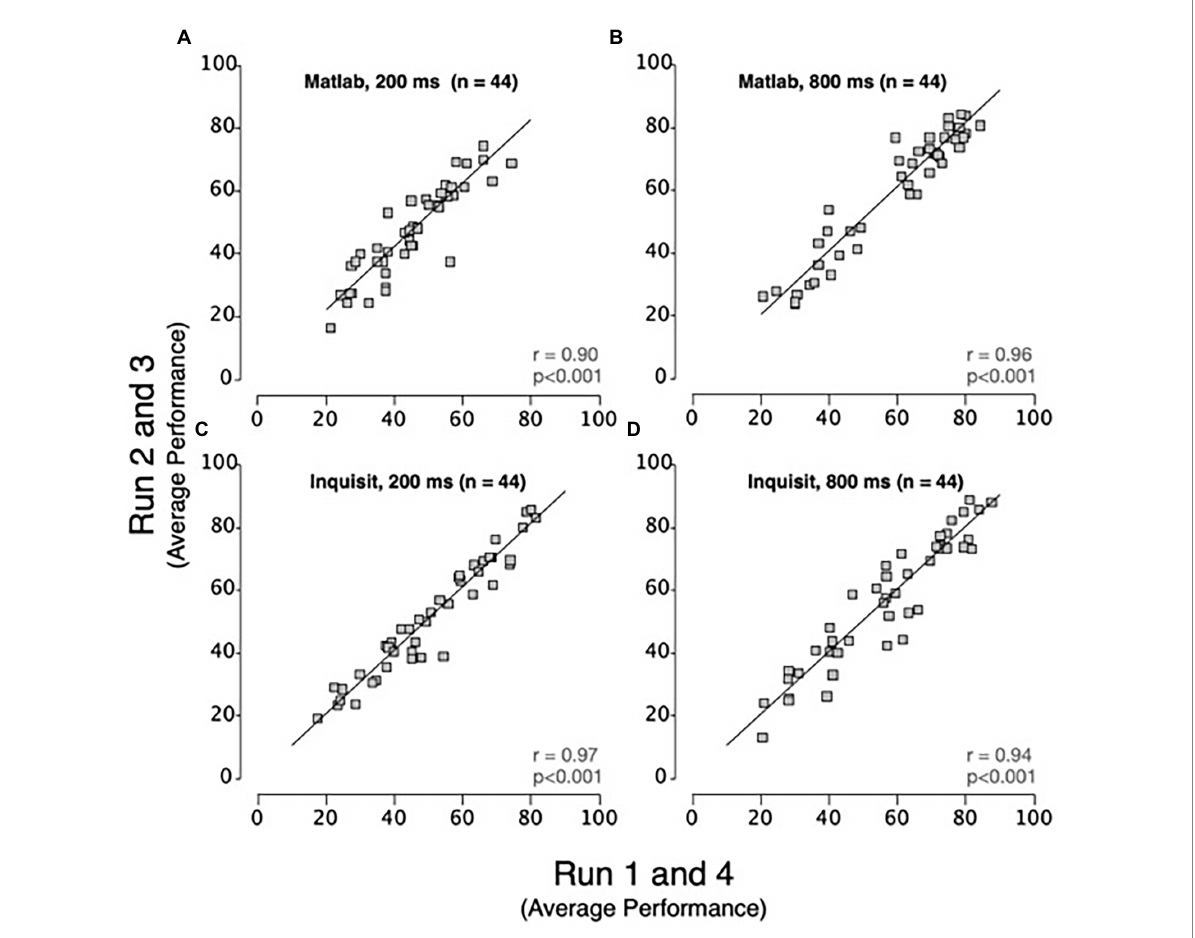
FIGURE 4 Scatter plots showing intra-platform relationships for MATLAB and Inquisit Millisecond platforms at 200 ms and 800 ms RDM durations. Each data point represents the mean performance of a single participant for runs 1 and 4 vs. runs 2 and 3 on MATLAB at (A) 200 ms and (B) 800 ms and on Inquisit Millisecond at (C) 200 ms and (D) 800 ms. The line is a trendline fitted to the data (Pearson’s correlation: p < 0.001 for both 200 ms and 800 ms durations on MATLAB and Inquisit